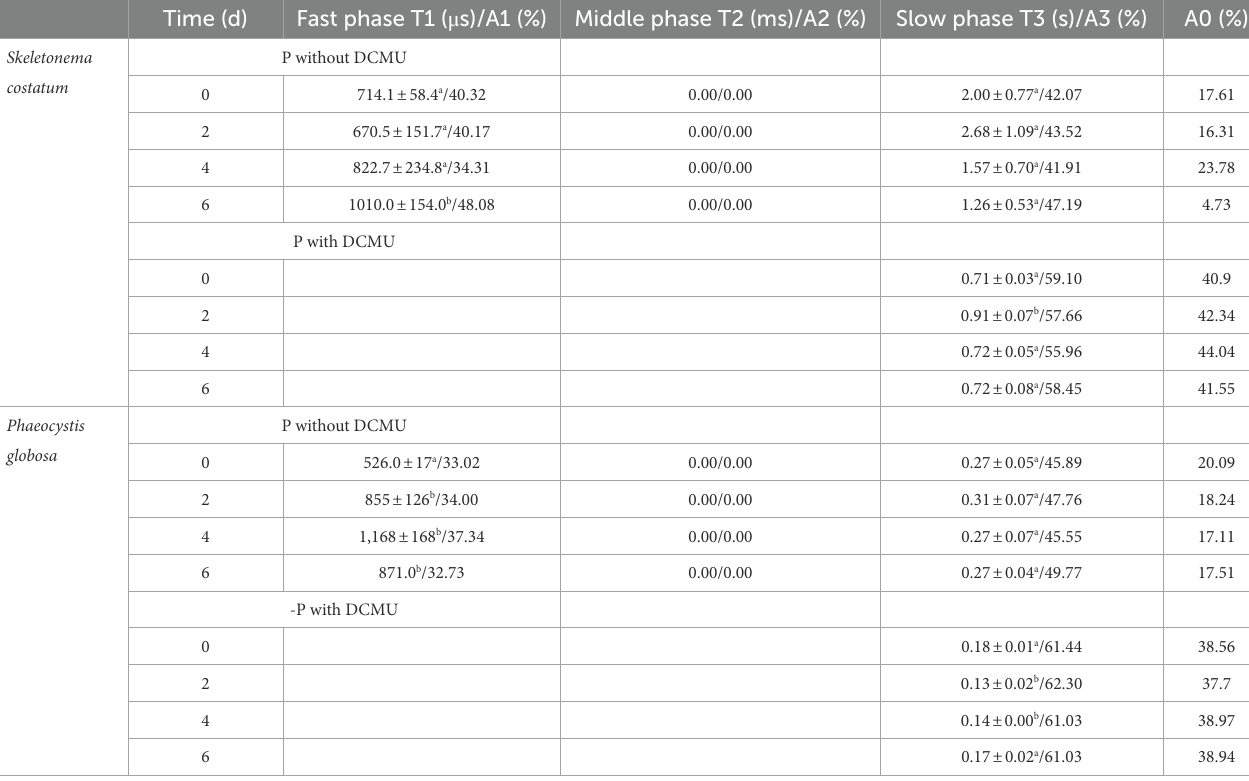
TABLE 1 Decay kinetics of flash-induced variable fluorescence in S . costatum and P . globosa